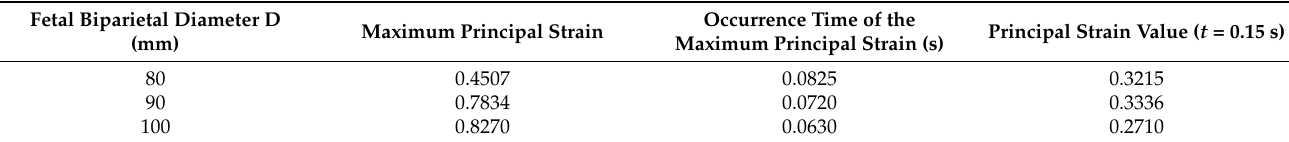
Table 5. Principal strain data